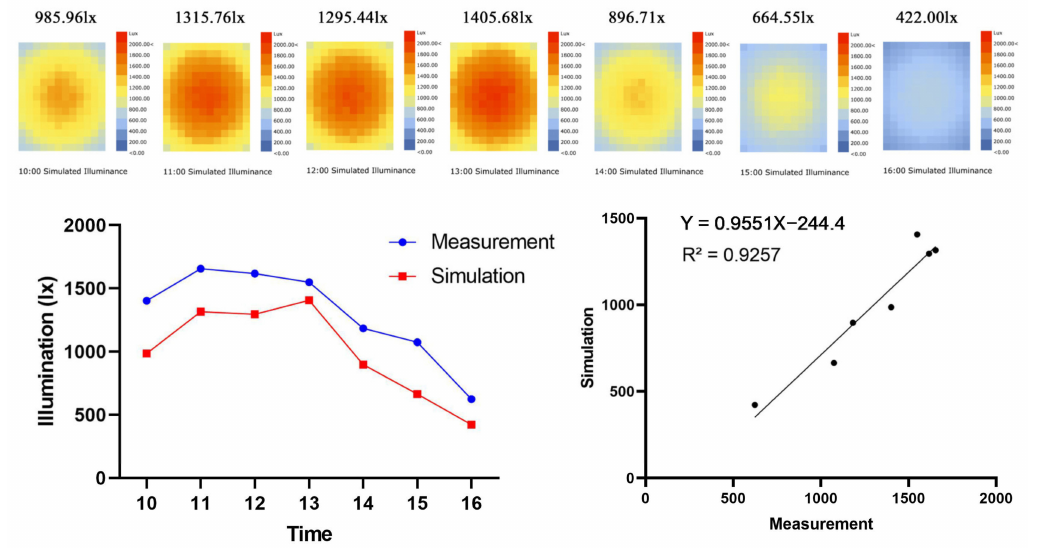
Figure 9. Baseline model daylight verification.